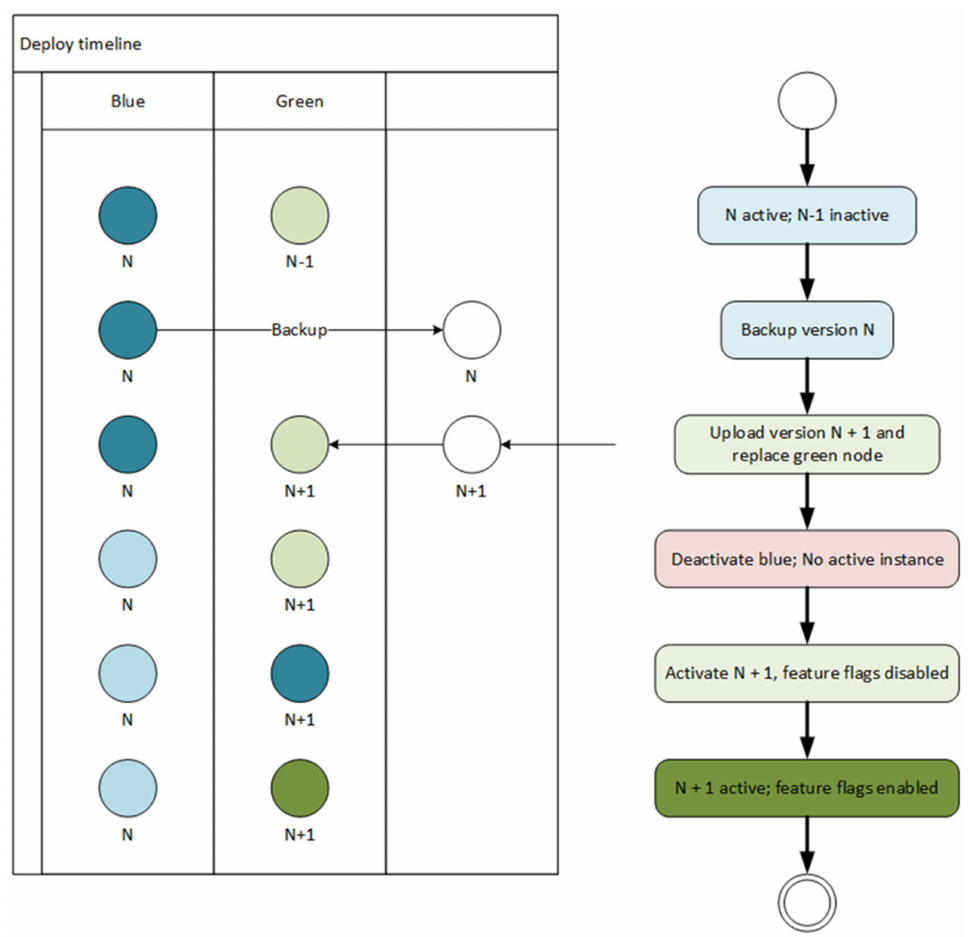
Figure 7. Blue/green + feature flags deployment strategy on a single